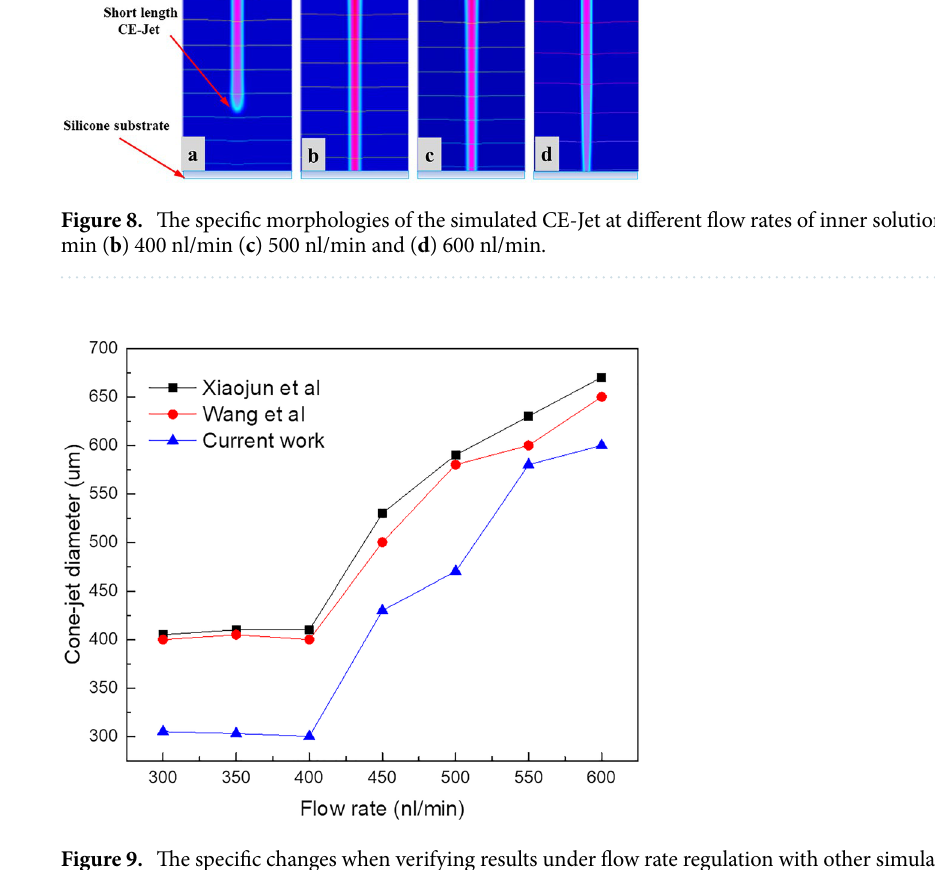
Figure 9. The specific changes when verifying results under flow rate regulation with other simulation